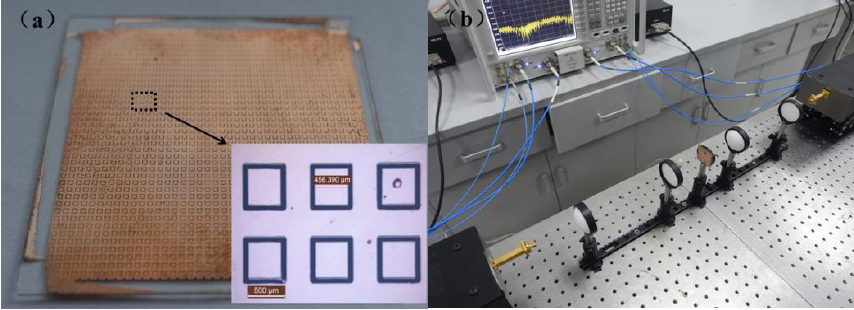
Figure 6. ( a ) Fabricated sample for the proposed structure and ( b ) experimental measurement setup.